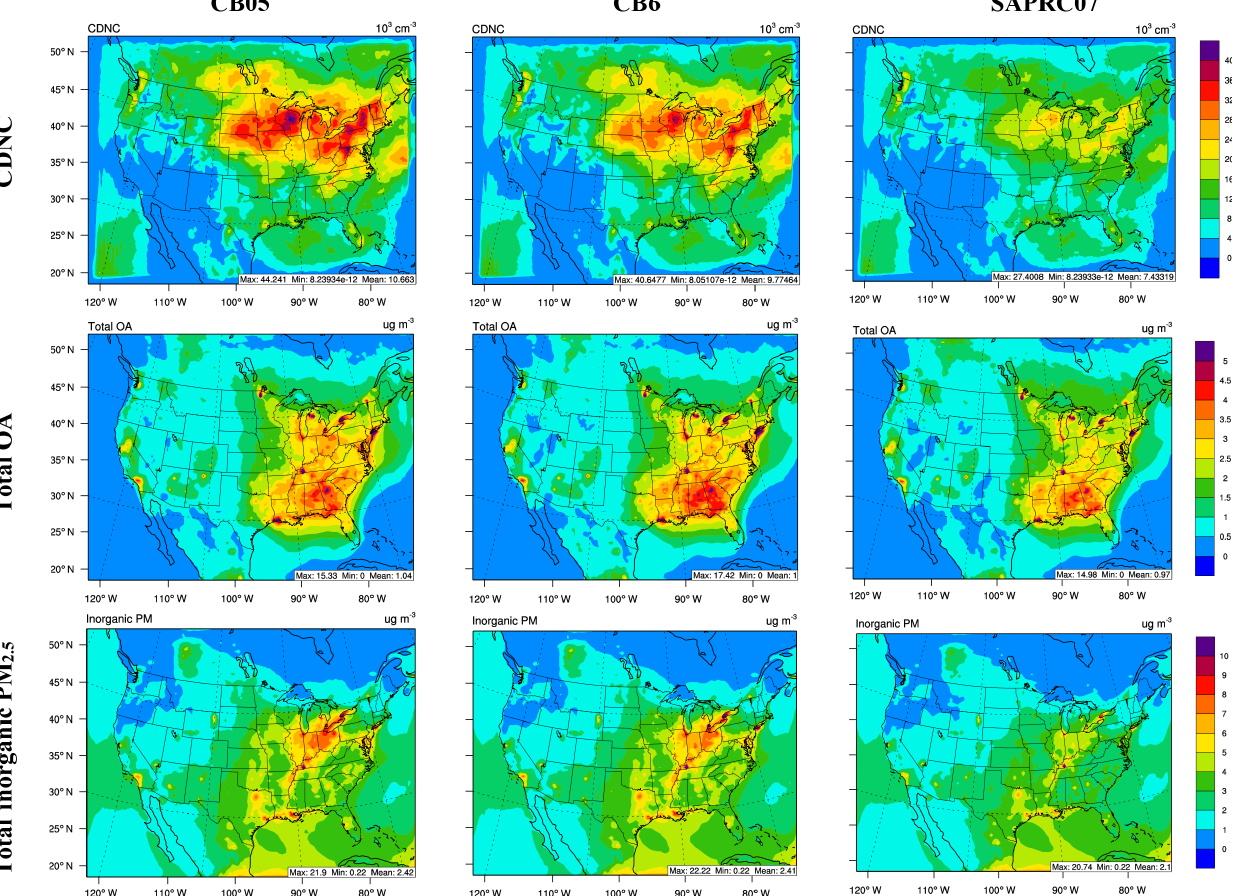
Figure 10. Spatial plots of total column CDNC, total surface OA, and total inorganic PM 2 . 5 concentrations from simulations with different gas-phase